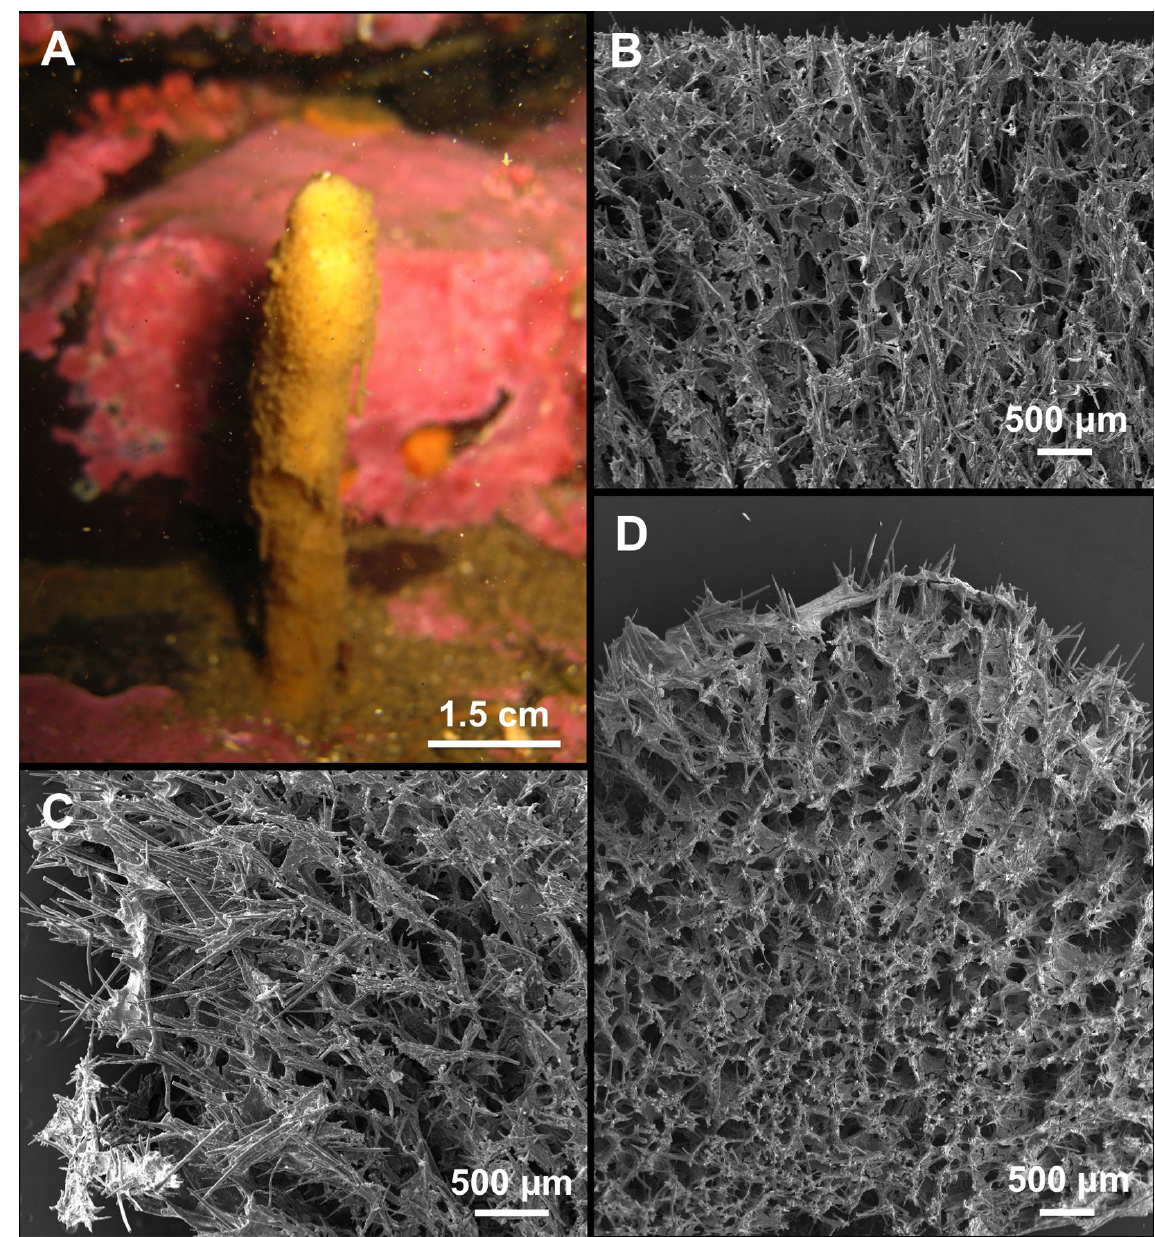
Fig. 3. Axinella cylindrica Bertolino, Costa & Pansini sp. nov., holotype (CILE 1; MSGN 61493). A . The holotype in life. B . Skeleton formed by a network of thin ascending plurispicular fibres. C . Extra- axial pumoreticulate skeleton. D . Skeleton differentiated in two regions, axial compressed reticulated and extra-axial